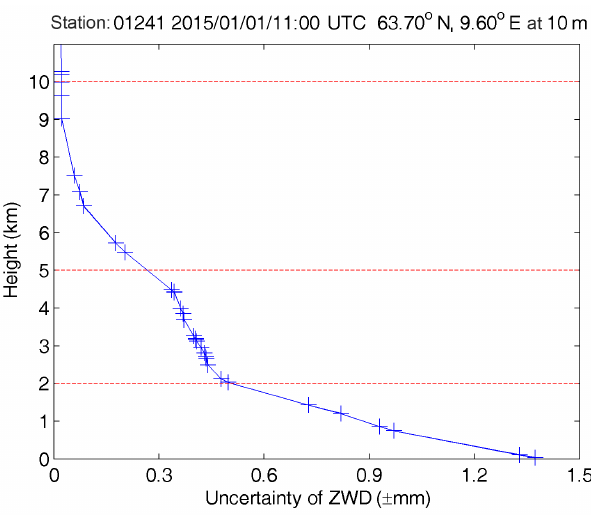
Figure 11. Uncertainty of ZWD with respect to height at sta- tion 01241 (63.70 ◦ N, 9.60 ◦ E at 10m) at 11:00UTC on 1 Jan- uary